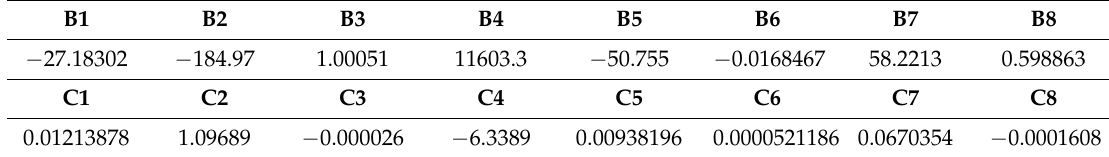
Table 3. Coefficients for desiccant wheel temperature and humidity ratio